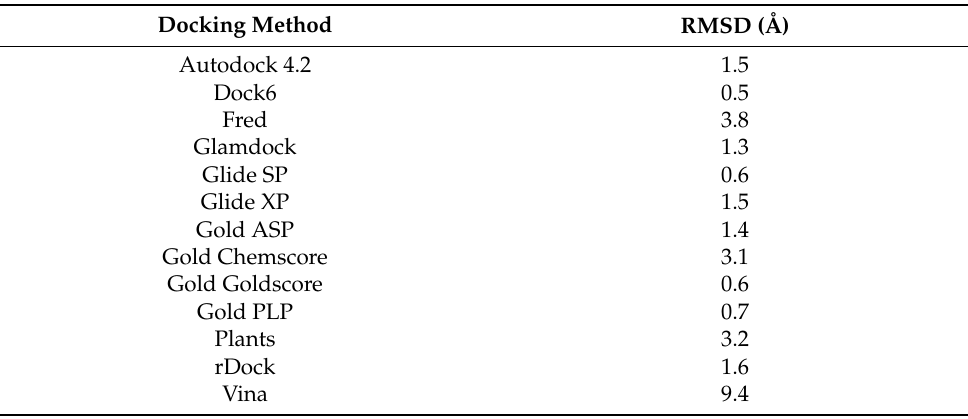
Table 2. Preliminary self-docking analyses on 5ZUN X-ray